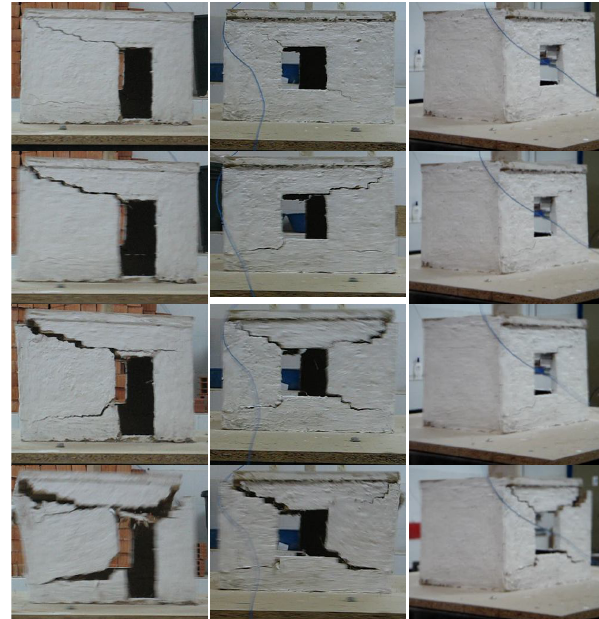
Fig. 10 Failure sequence of specimen CF1